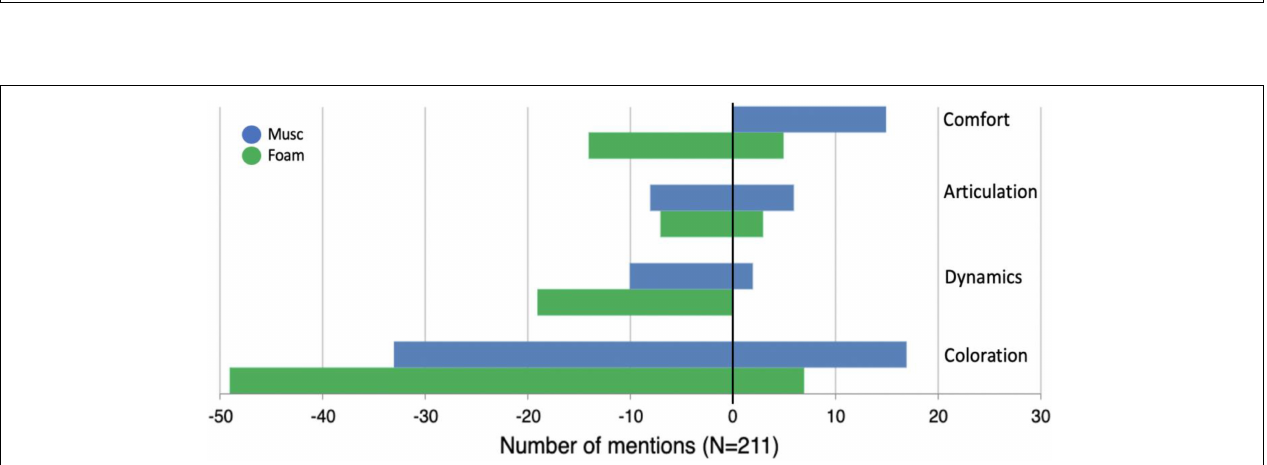
FIGURE 6 | Mentions of sound quality descriptors for the foam and musician earplugs conditions. Mentions with a negative connotation are displayed with negative values; mentions with a positive connotation with positive values. The number of mentions collected is the absolute value.